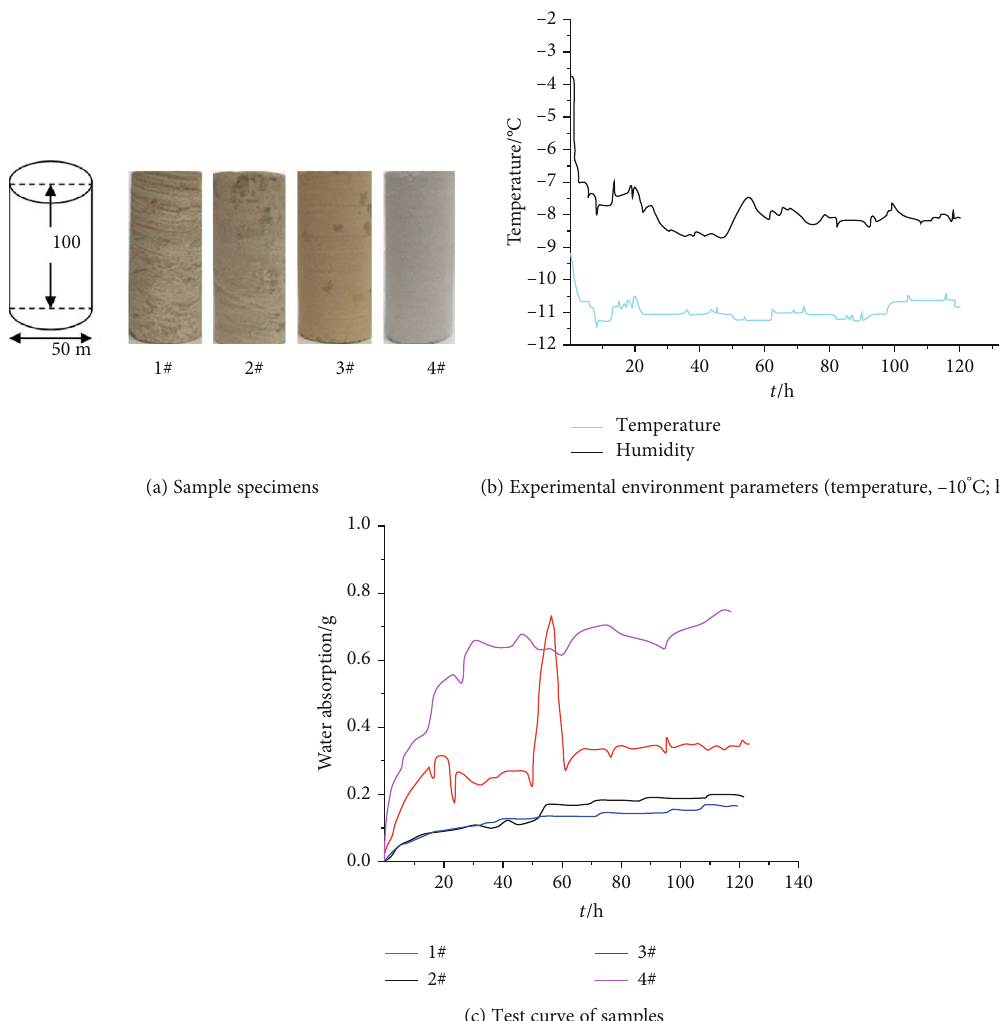
Figure 29: Gaseous water adsorption experiment of the mudstone samples from Mogao Grottoes in the summer in Group III.